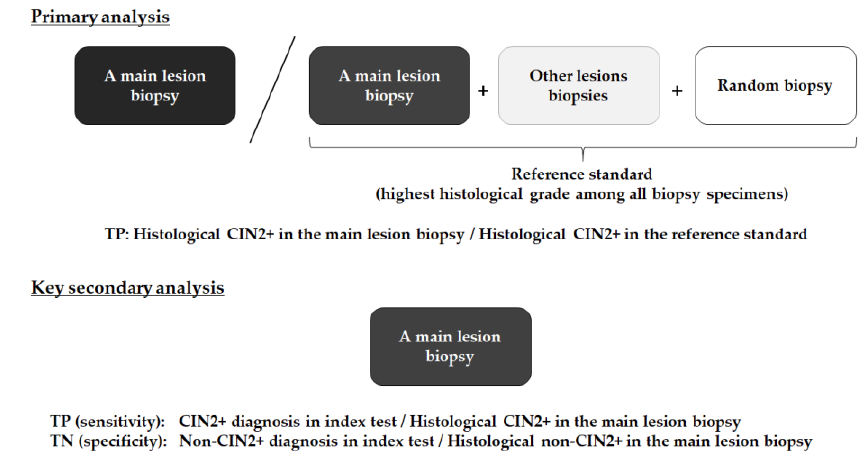
Figure 4. Definition of primary and key secondary analyses. TP, true positive; TN, true negative; CIN2+, cervical intraepithelial neoplasia grade 2 or